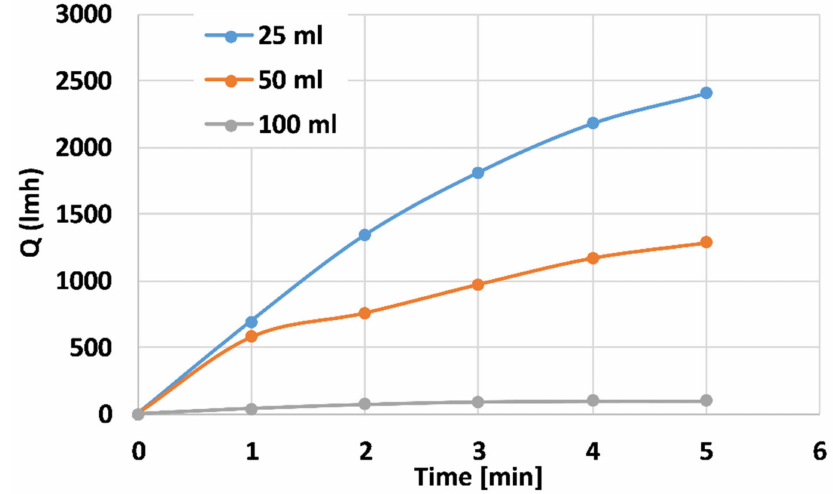
Figure 7. Distilled water flux properties of the 25 mL (blue), 50 mL (orange), and 100 mL (grey) PANI-coated CNT membranes at the trans-membranal pressure drop of 4 bars.